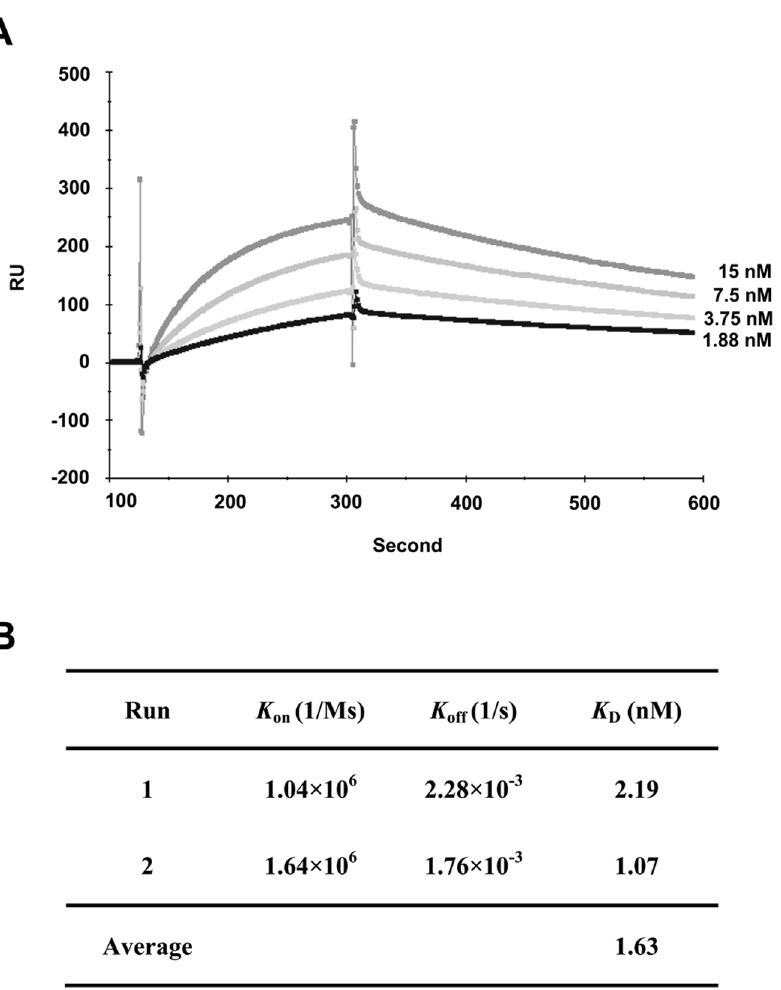
Figure 5. Affinity determination of anti-idiotype scFv Hc5 by surface plasmon resonance. The idiotype chimeric anti-CD22 MAb was immobilized onto Biacore CM5 chip and the anti-Id scFv Hc5 was then applied to determine the binding affinity as described in Methods. (A) Kinetic binding of anti-Id scFv Hc5 was measured by surface plasmon resonance using the BIAcore 3000 system. Numbers in the right margins indicate the concentrations of anti-Id scFv used for each curve. Data shown is a representative of two separate experiments with similar results. (B) The association rate ( k on ), dissociation rate ( k off ) and affinity constant ( K D ) were derived using BIAevaluation software from two separate experiments.